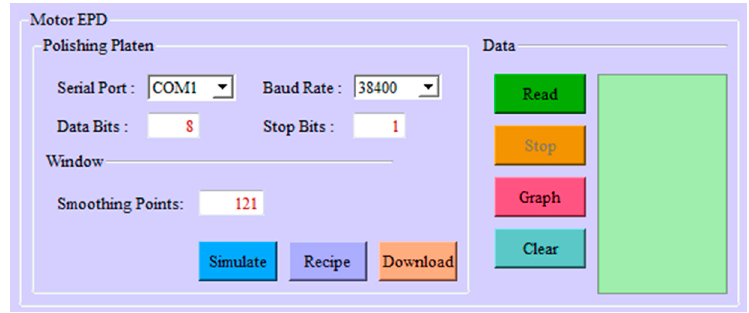
Figure 4. The graphic user interface (GUI) of data acquisition system.